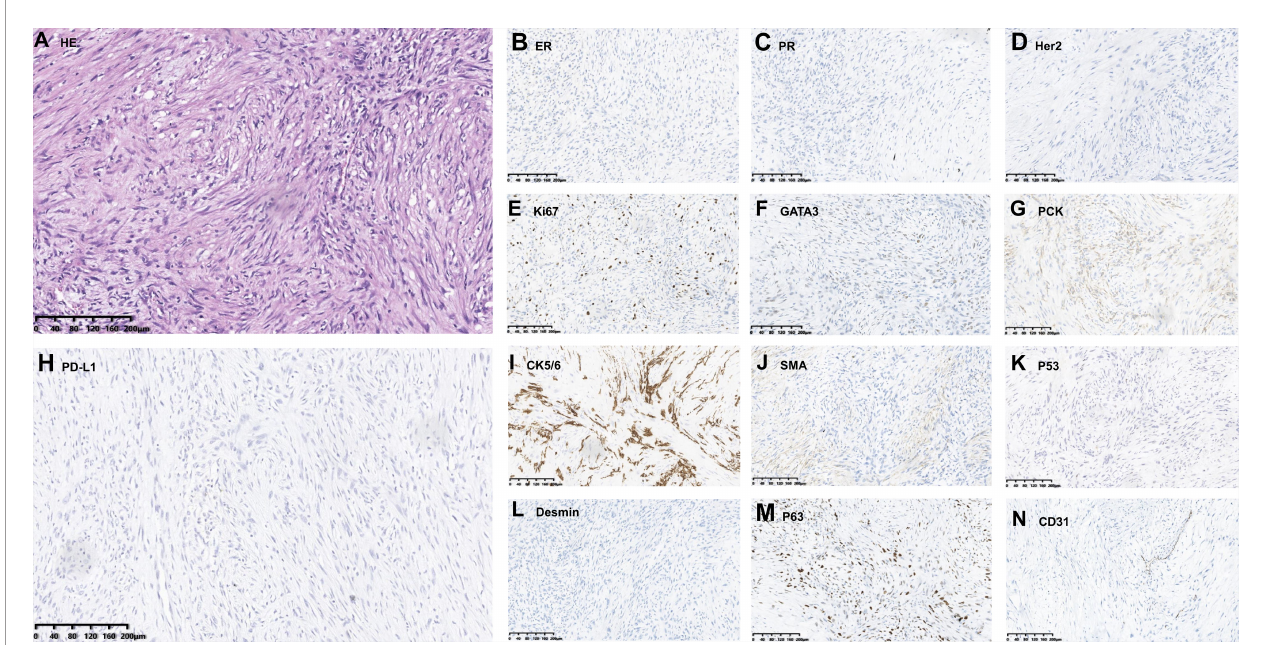
FIGURE 2 | Pathological examination showed spindle cell morphology ( A , H&E). (B – N) Immunohistochemistry data: ER ( − ), PR ( − ), Her2( − ), Ki-67 (+, positive proportion about 20%), GATA3 (+), PCK (+), PD-L1( − , positive proportion about <1%), CD5/6 (+), SMA (+), P53( − ), Desmin ( − ), P63(+), and CD31 ( − ) supported the diagnosis. Original magni fi cation: (A – N) ,